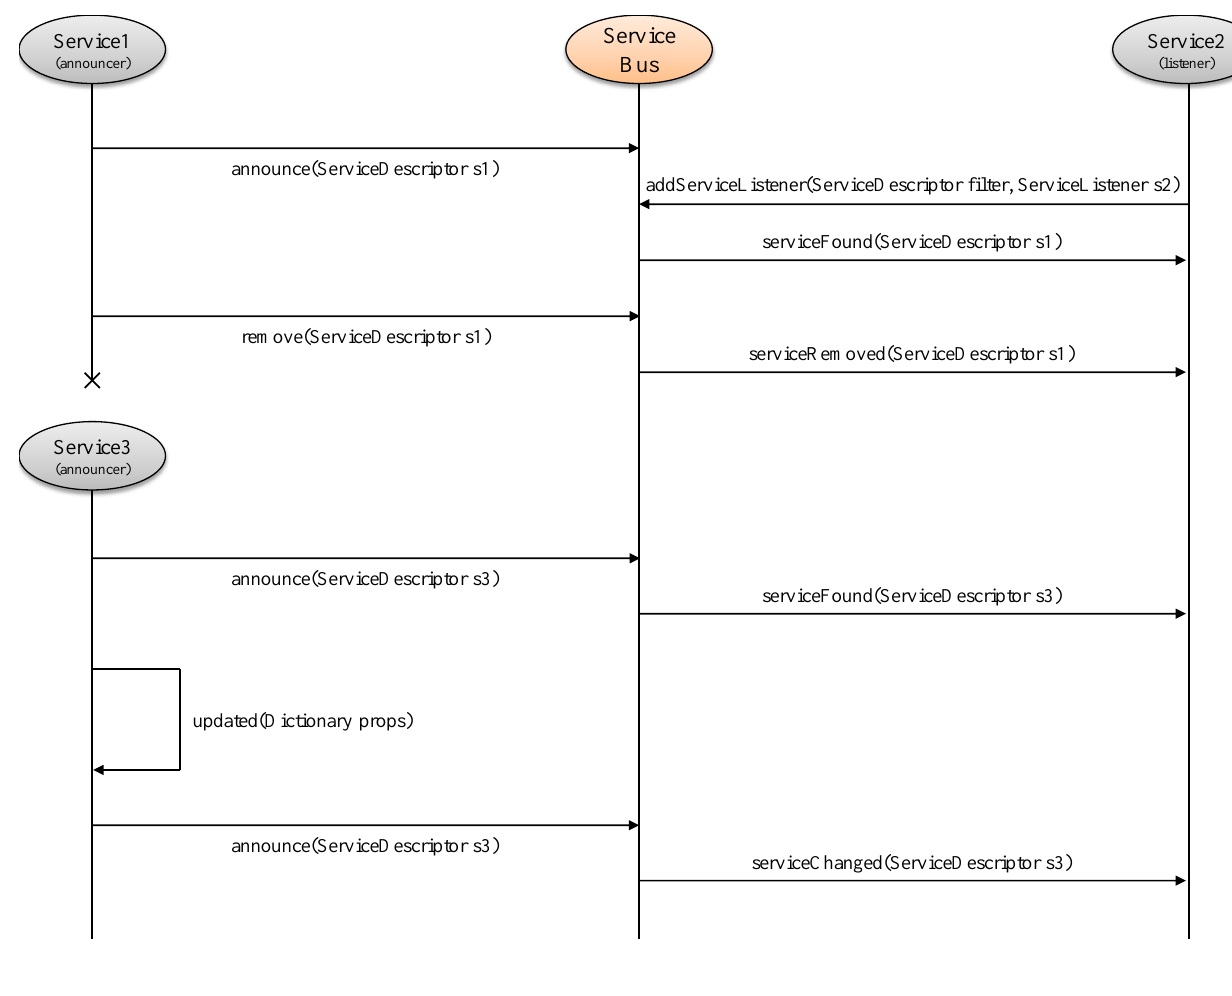
Figure 5. The announce-listen protocol